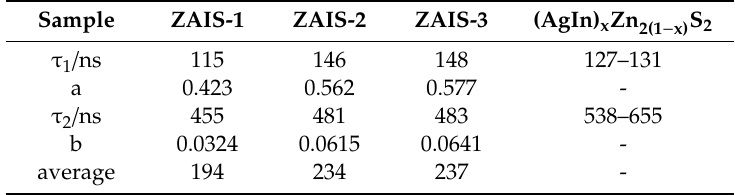
Table 3. Decay times and amplitude constant ratios of ZAIS-1, ZAIS-2, and